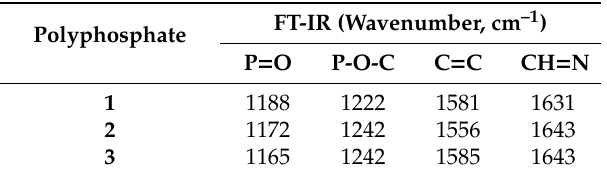
Table 2. FT-IR spectral data for 1–3 .